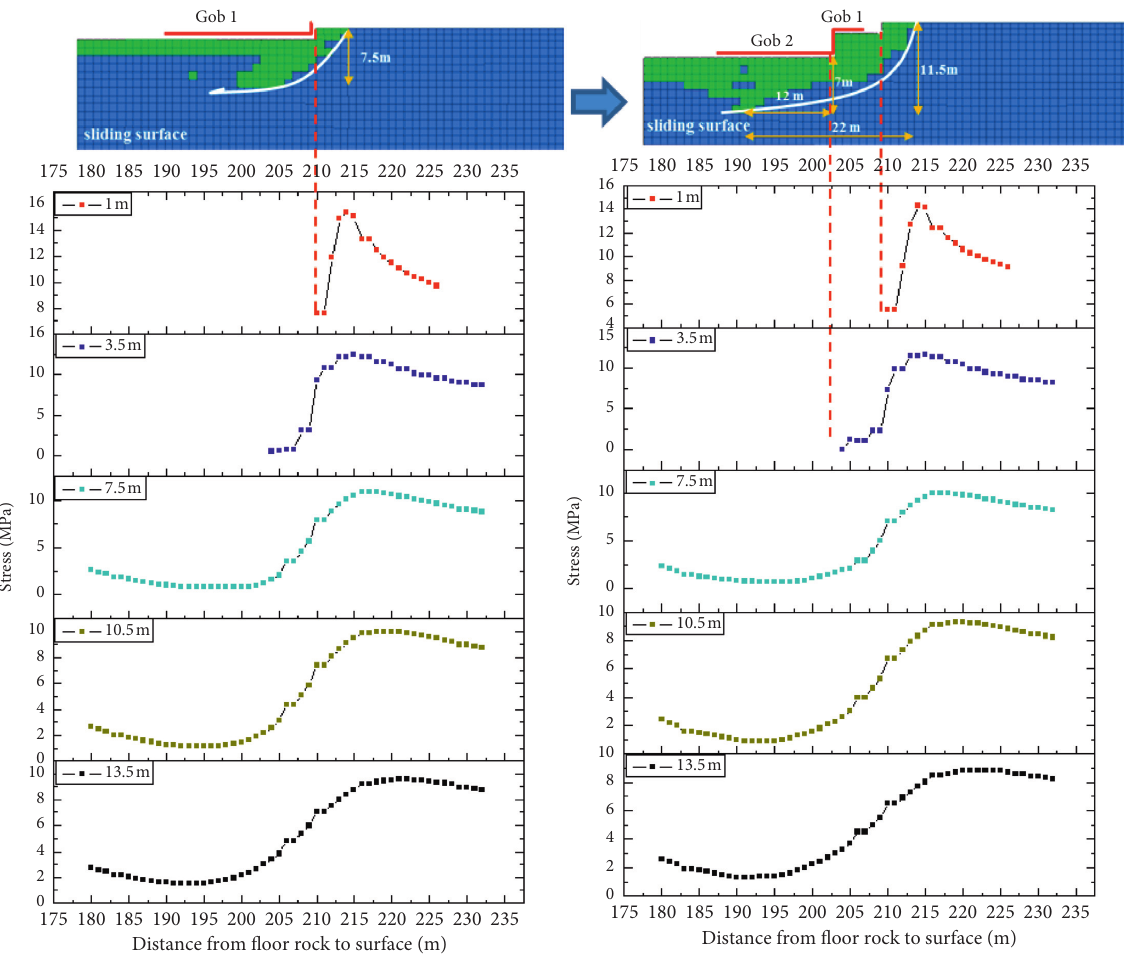
Figure 16: Double gobs in close coal seams.